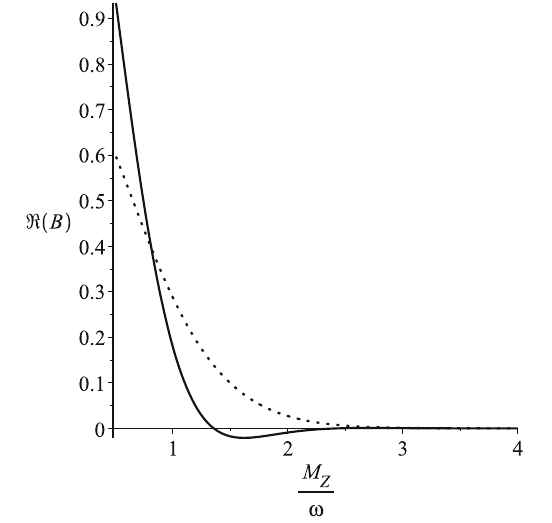
Fig. 4 Imaginary part of B k as a function of parameter M Z /ω . Solid line is for p = 0 . 3 , p (cid:11) = 0 . 5 , P = 0 . 2, while the point line is for p = 0 . 2 , p (cid:11) = 0 . 3 , P = 0 . 5